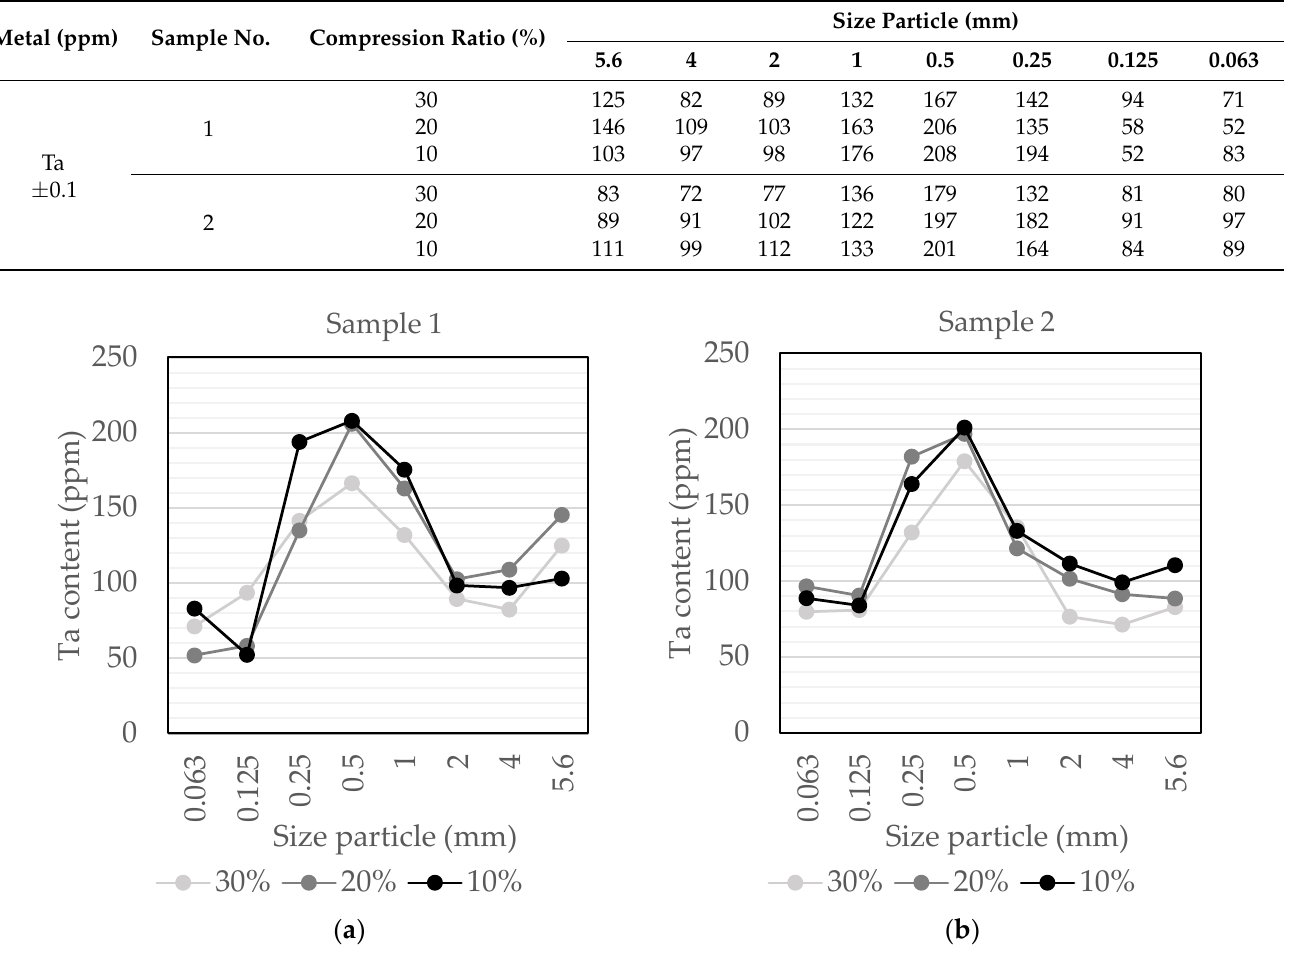
Figure 4. Representative trace elements content of the Penouta ore after compression breakage for tantalum for sample 1 ( a ) and sample 2 ( b ) from experimental data [25] .